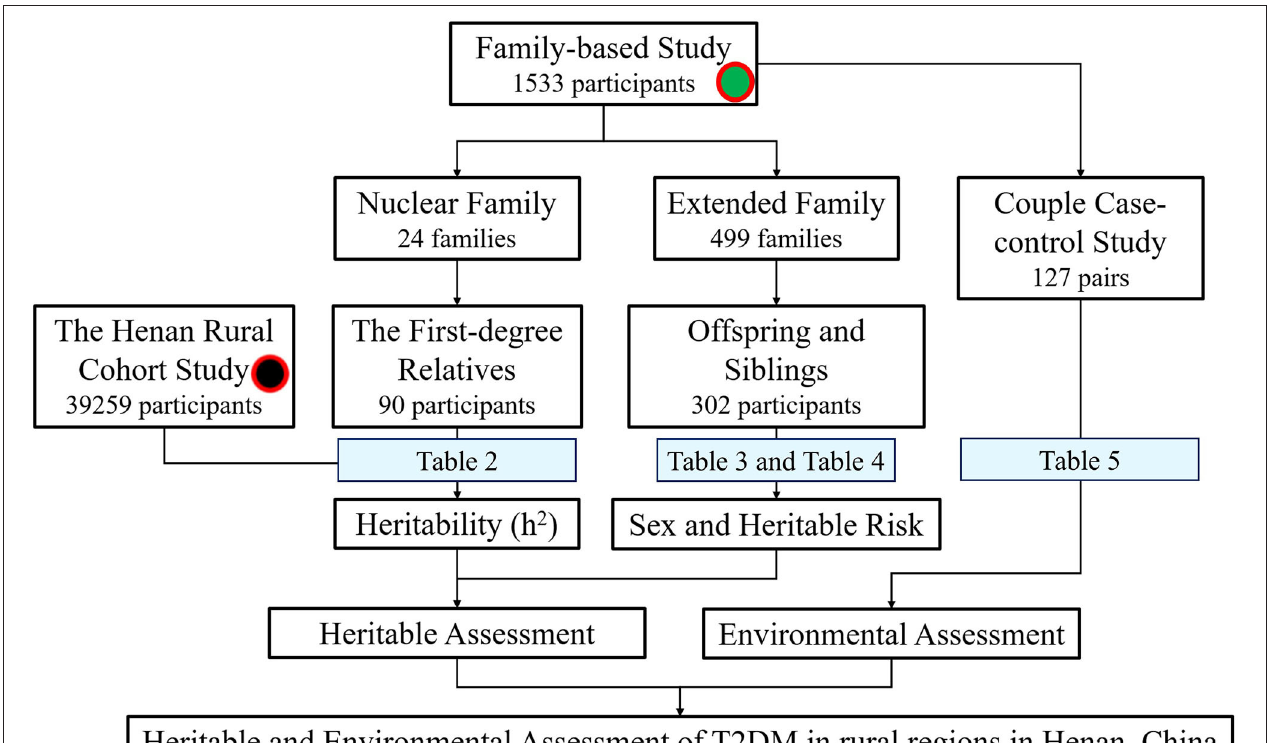
FIGURE 2 | Research flowchart.